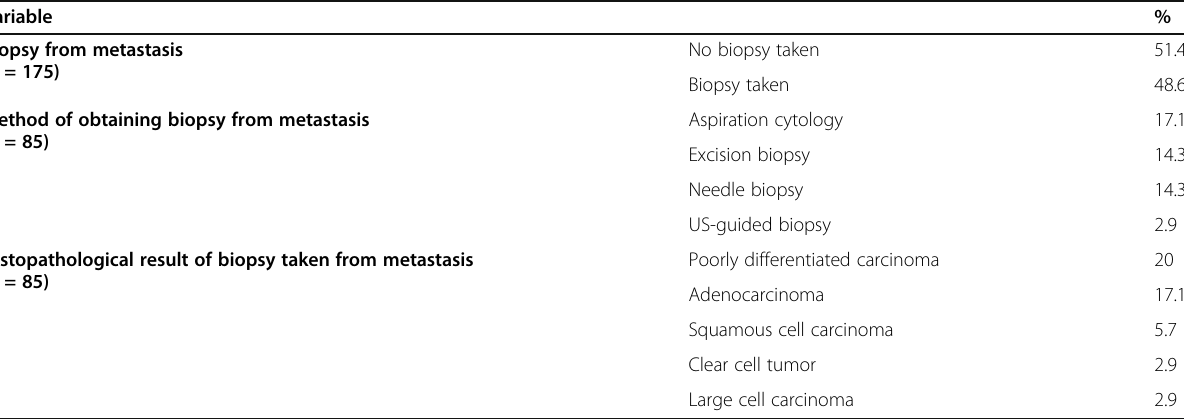
Table 2 Results of biopsy obtained from metastasis Variable Biopsy from metastasis ( n = 175) Method of obtaining biopsy from metastasis ( n =